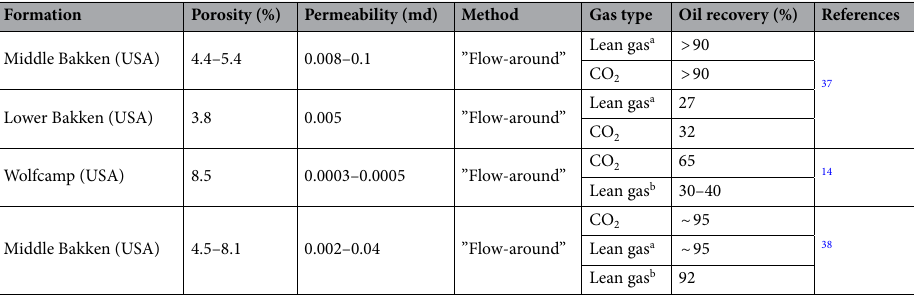
Table 1. Comparison of core-based HNP experiments with CO 2 and lean gas in tight oil/gas formations. a Simplified lean gas (85% CH b Pure lean gas (100% CH 4 + 15% C 2 H 6 ) is used in the tests. 4 ) is used in the tests.